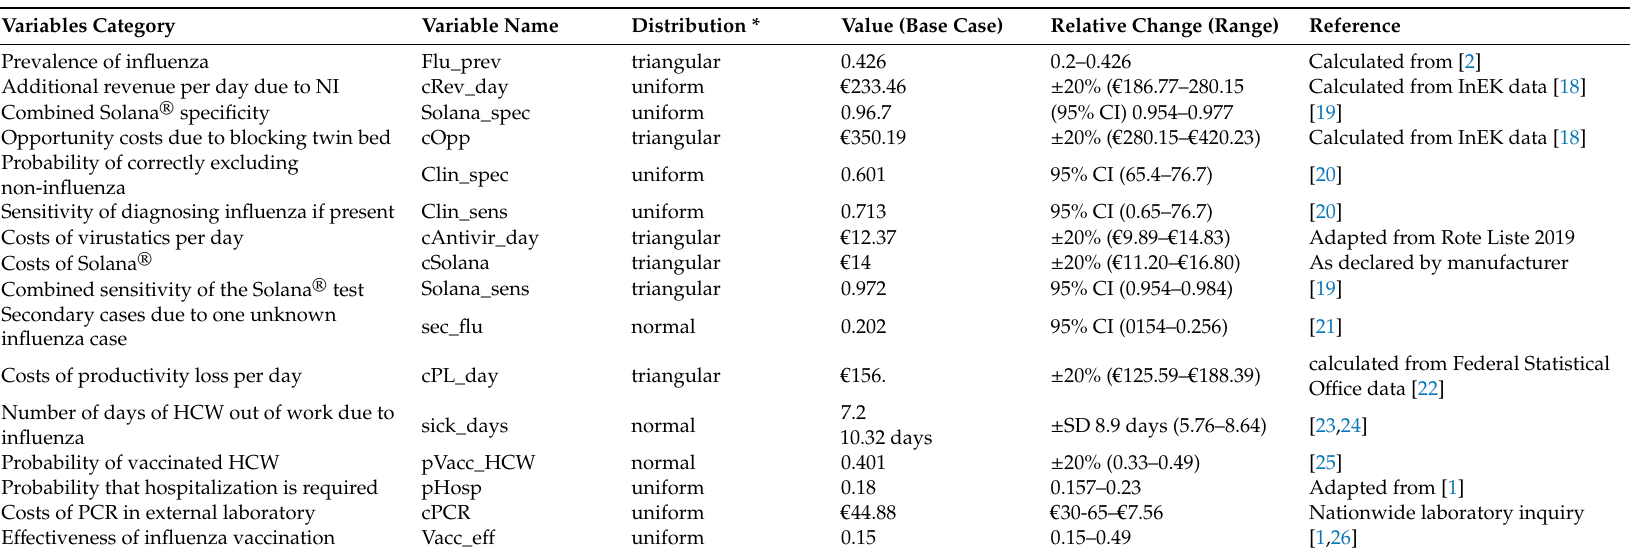
Table 1. Input for cost–benefit